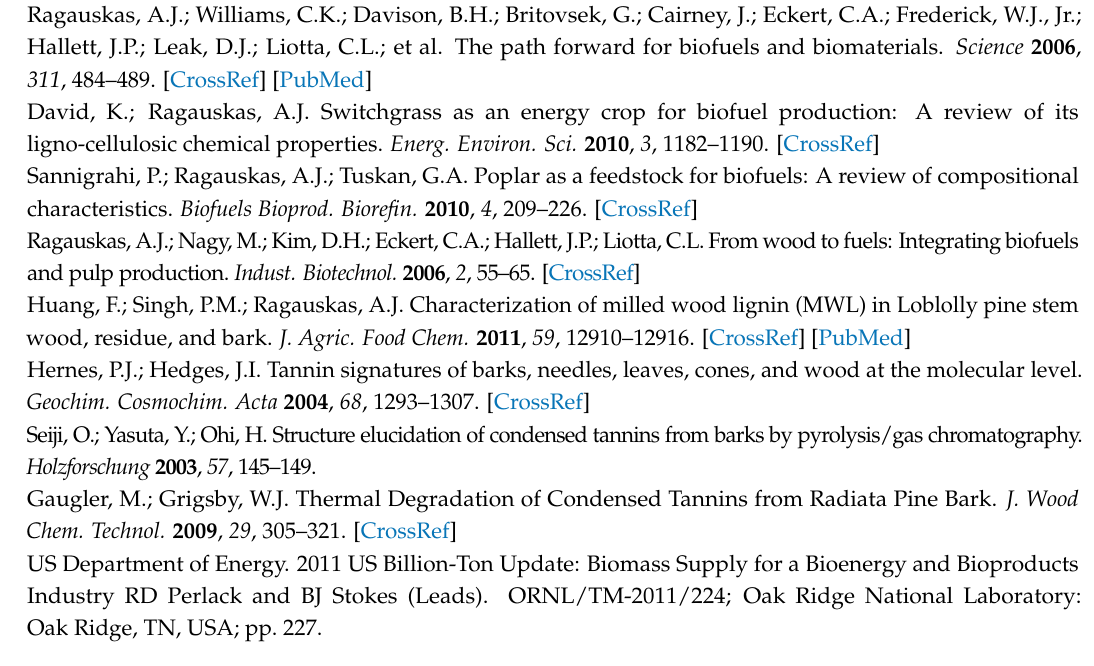
and pine residue pyrolysis oil (right) produced at 600 ◦ C; Figure S6a: Methoxyl groups in the HSQC-NMR spectra for artificial mixture of pyrolysis oils produced from lignin, tannin, cellulose, and hemicellulose (left) and pine bark pyrolysis oil (right) produced at 600 ◦ C; Figure S6b: Methoxyl groups in the HSQC-NMR spectra for artificial mixture of pyrolysis oils produced from lignin, tannin, cellulose, and hemicellulose (left) and pine residue pyrolysis oil (right) produced at 600 ◦ C; Figure S7: HSQC-NMR for standard mixtures of pyrolysis oil model compounds; Figure S8: HSQC-NMR for pyrolysis oil produced from a pilot plant reactor; Figure S9a: Integrations and linear fit for aromatic C–H bonds in the HSQC-NMR for standard mixtures (100%, 50%, 25%, 10%, and 5% concentrations) of pyrolysis oil model compounds; Figure S9b: Integrations and linear fit for aliphatic C–H bonds in the HSQC-NMR for standard mixtures (100%, 50%, 25%, 10%, and 5% concentrations) of pyrolysis oil model compounds; Figure S9c: Integrations and linear fit for levoglucosan C–H bonds in the HSQC-NMR for standard mixtures (100%, 50%, 25%, 10%, and 5% concentrations) of pyrolysis oil model compounds; Figure S9d: Integrations and linear fit for aliphatic C–H bonds in the HSQC-NMR for standard mixtures (100%, 50%, 25%, 10%, and 5% concentrations) of pyrolysis oil model compounds; Figure S10: Quantitative 13 C NMR and DEPT 135 and DEPT 90 (from top to bottom) for the pyrolysis oil produced from a pilot plant reactor; Table S1: Quantitative 13C NMR results for the tannin and lignin used in this study; Table S2: Functional group recovery ratios for artificial Table S4: Certified values for standard #1; Table S5: Certified values for standard #2; Table S6: Evaluations for quantitative 13C NMR of standard #1; Table S7: Evaluations for quantitative 13 C NMR of standard #2; Table S8: T1 value for different functional groups in pyrolysis oil produced from a pilot plant reactor when employing 5 mg/ml Cr(acac)3 as a relaxing reagent; Table S9: Integrations for each 1 mmol carbon in the functional groups calculated from analysis for artificial mixtures of pyrolysis oil (produced from a pilot plant reactor) and pyrolysis oil model compounds based on quantitative 13 C NMR; Table S10: Comparisons of quantitative 13 C NMR and HSQC-NMR investigations on pyrolysis oil sample (a pilot plant product); Table S11: 1 H and 13 C NMR chemical shift assignments for the compounds reported present in tannin pyrolysis oils; Table S12: 13 C NMR chemical shift assignments for the compounds reported present in hemicellulose pyrolysis oils. The compounds in this database are based on References